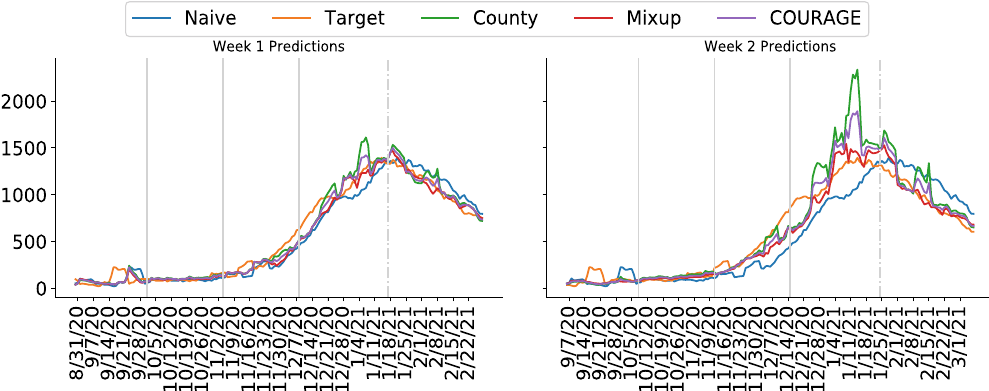
Figure 1. New York’s weekly total number of deaths for Week 1 (left) predictions and Week 2 (right) predictions. Vertical lines separate different prediction periods as in Table 2. The last dashed vertical line marks the prediction period of recent data using our last trained model. “Target” is the true reported number of deaths of New York. More plots for other major states are presented in Supplementary Information.